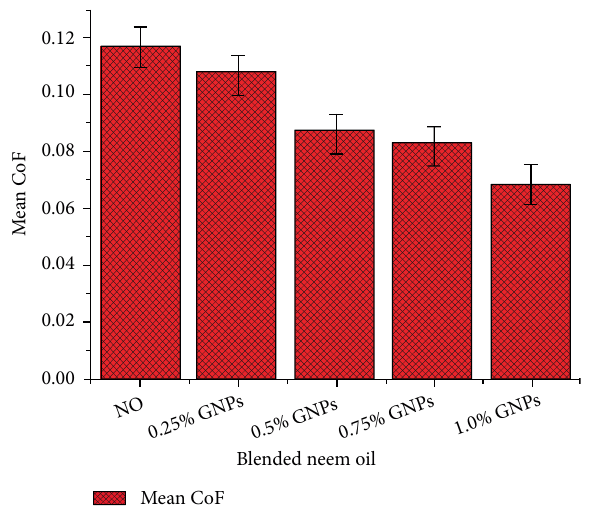
Figure 7: Mean coefficient of friction of GNPs-neem